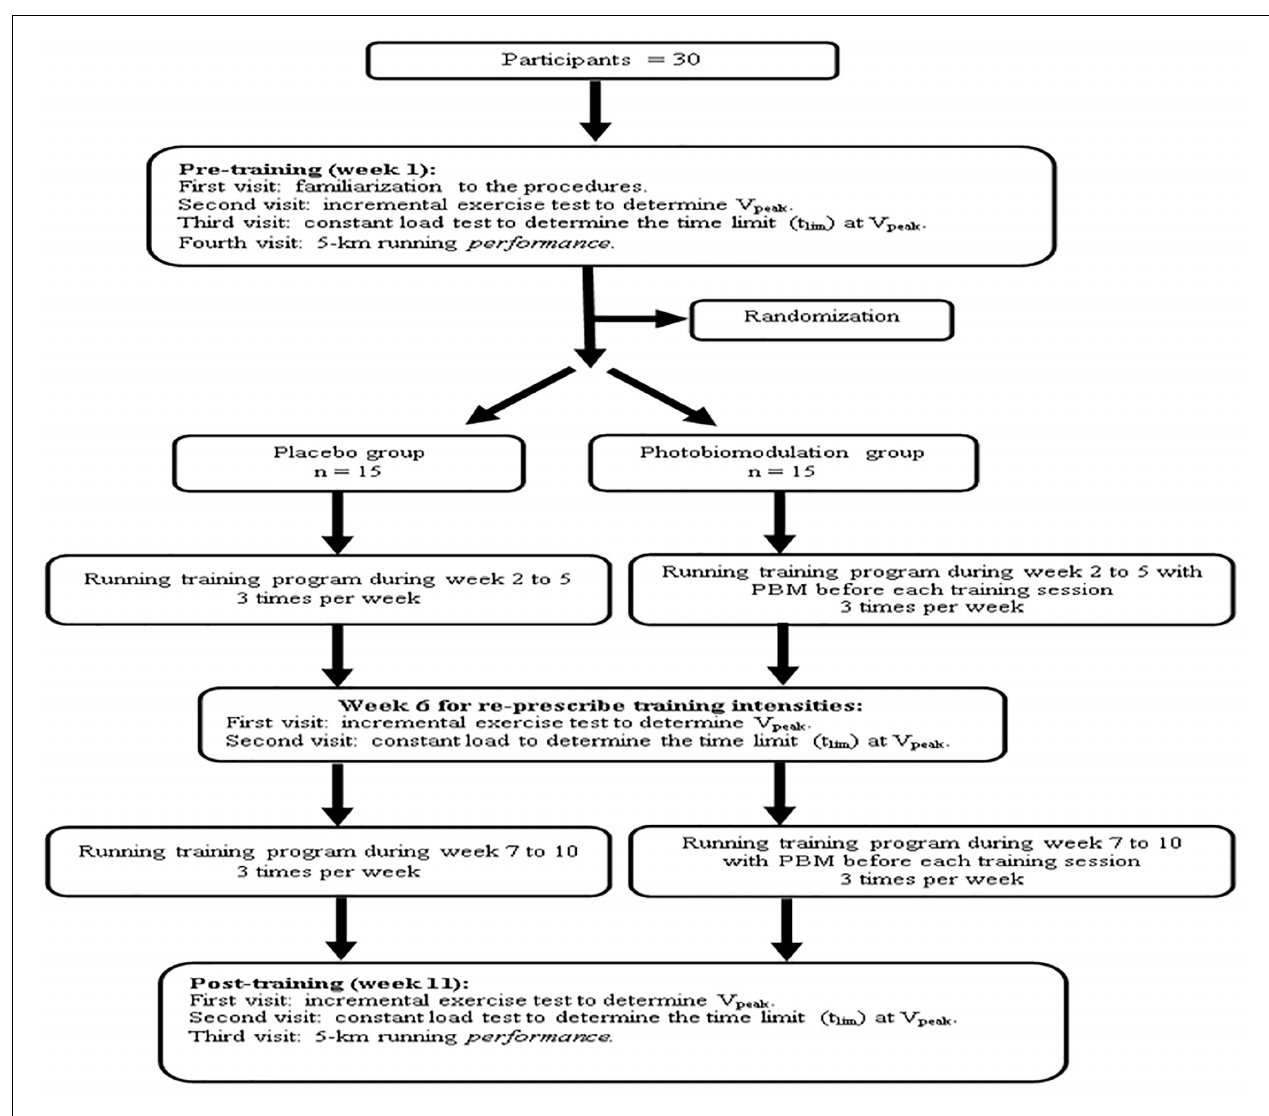
FIGURE 1 | Flow chart of the study